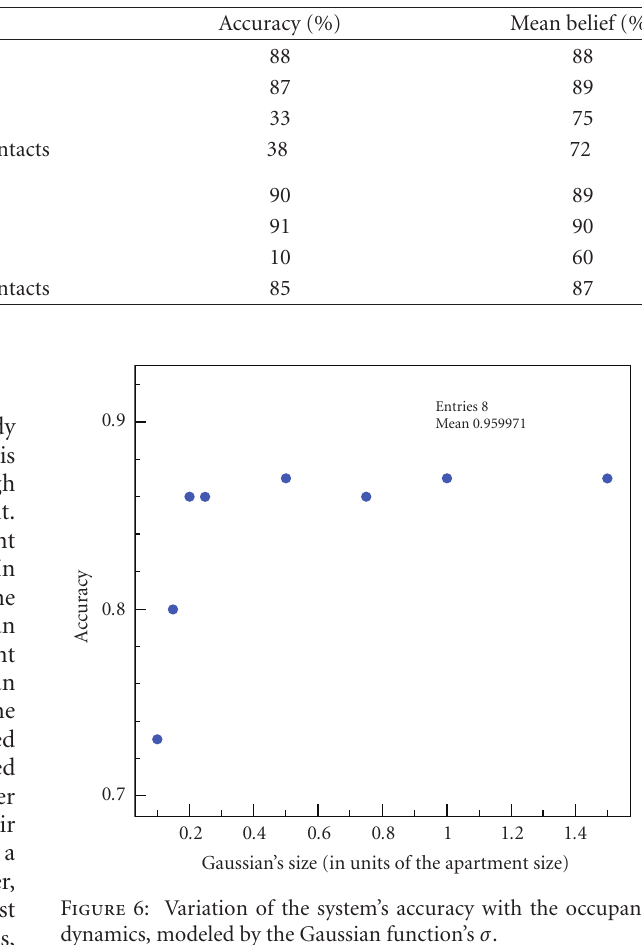
Table 4: Accuracy and mean belief per activity, using di ff erent sensors.